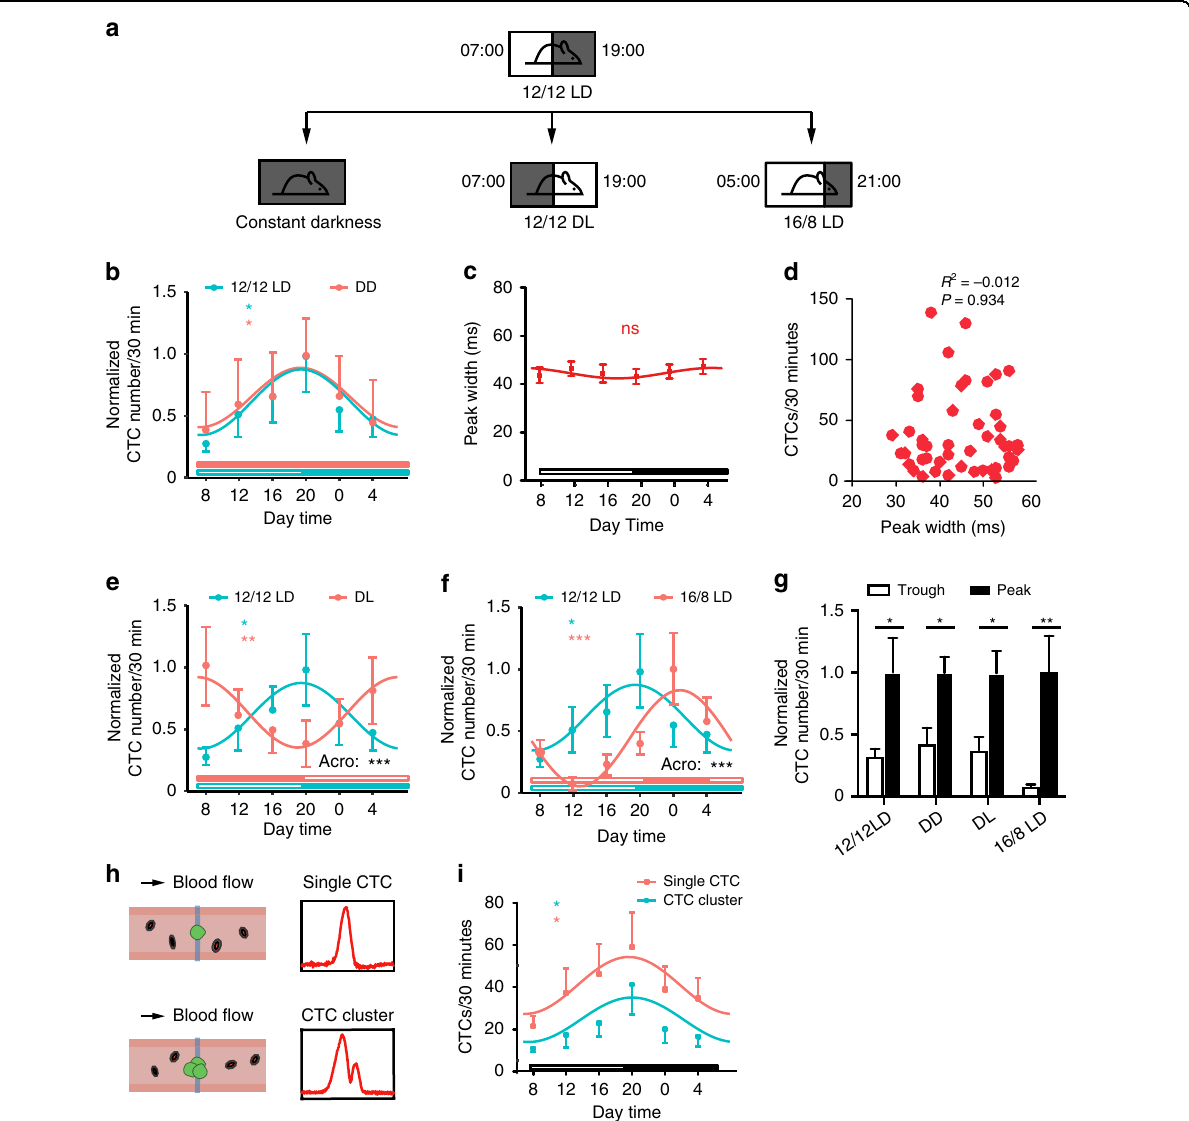
Fig. 3 CTC counts exhibited circadian oscillation in mice monitored by fl uorescence IVFC. a Schematic of the light-dark cycle. b Circadian rhythm of CTCs in mice maintained under 12/12 LD and DD conditions. Un fi lled bars: light phase, fi lled bars: dark phase. The statistical signi fi cance of the fl uctuation was evaluated using Cosinor analysis, n = 5 – 8 mice. c Daily variations in the peak widths of the IVFC signals detected in mice maintained under 12/12 LD conditions. Cosinor analysis revealed no signi fi cant fl uctuation, n = 8 mice. d Pearson correlation analysis of the CTC count with the peak width ( R 2 = − 0.012, P = 0.934). e Circadian rhythm of CTCs in mice maintained under 12/12 LD and DL conditions. The statistical signi fi cance of the fl uctuation was evaluated using Cosinor analysis, n = 3 – 8 mice. There was a signi fi cant difference in acrophase (Acro) between the 12/12 LD and DL groups. f Circadian rhythm of CTCs in mice maintained under 12/12 LD and 16/8 LD conditions. The statistical signi fi cance of the fl uctuation was evaluated using Cosinor analysis, n = 6 – 8 mice. There was a signi fi cant difference in acrophase (Acro) between the 12/12 LD and 16/8 LD groups. g CTC counts at the peak and trough of the rhythm, n = 3 – 8 mice, unpaired t -test. h Schematic diagram showing the fl uorescence IVFC signals of a single CTC and a CTC cluster. i Daily variation in the numbers of single CTC and CTC clusters detected in mice maintained under 12/12 LD conditions. * P < 0.05, ** P < 0.01, *** P < 0.001. All data are presented as the mean